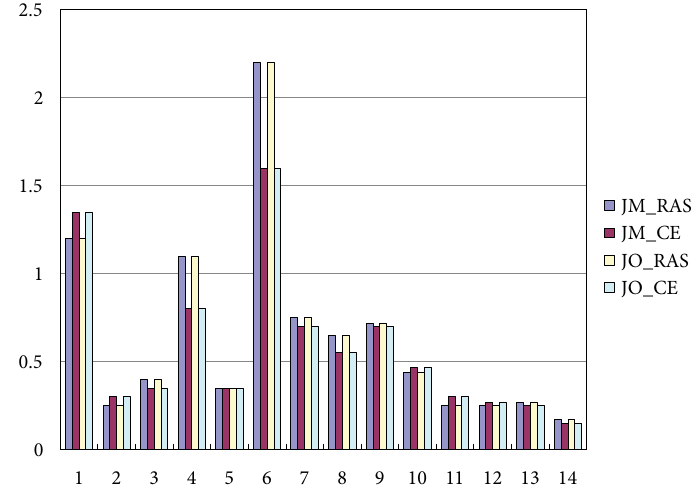
Fig. 3. Comparison of the two estimation methods from the perspective of information